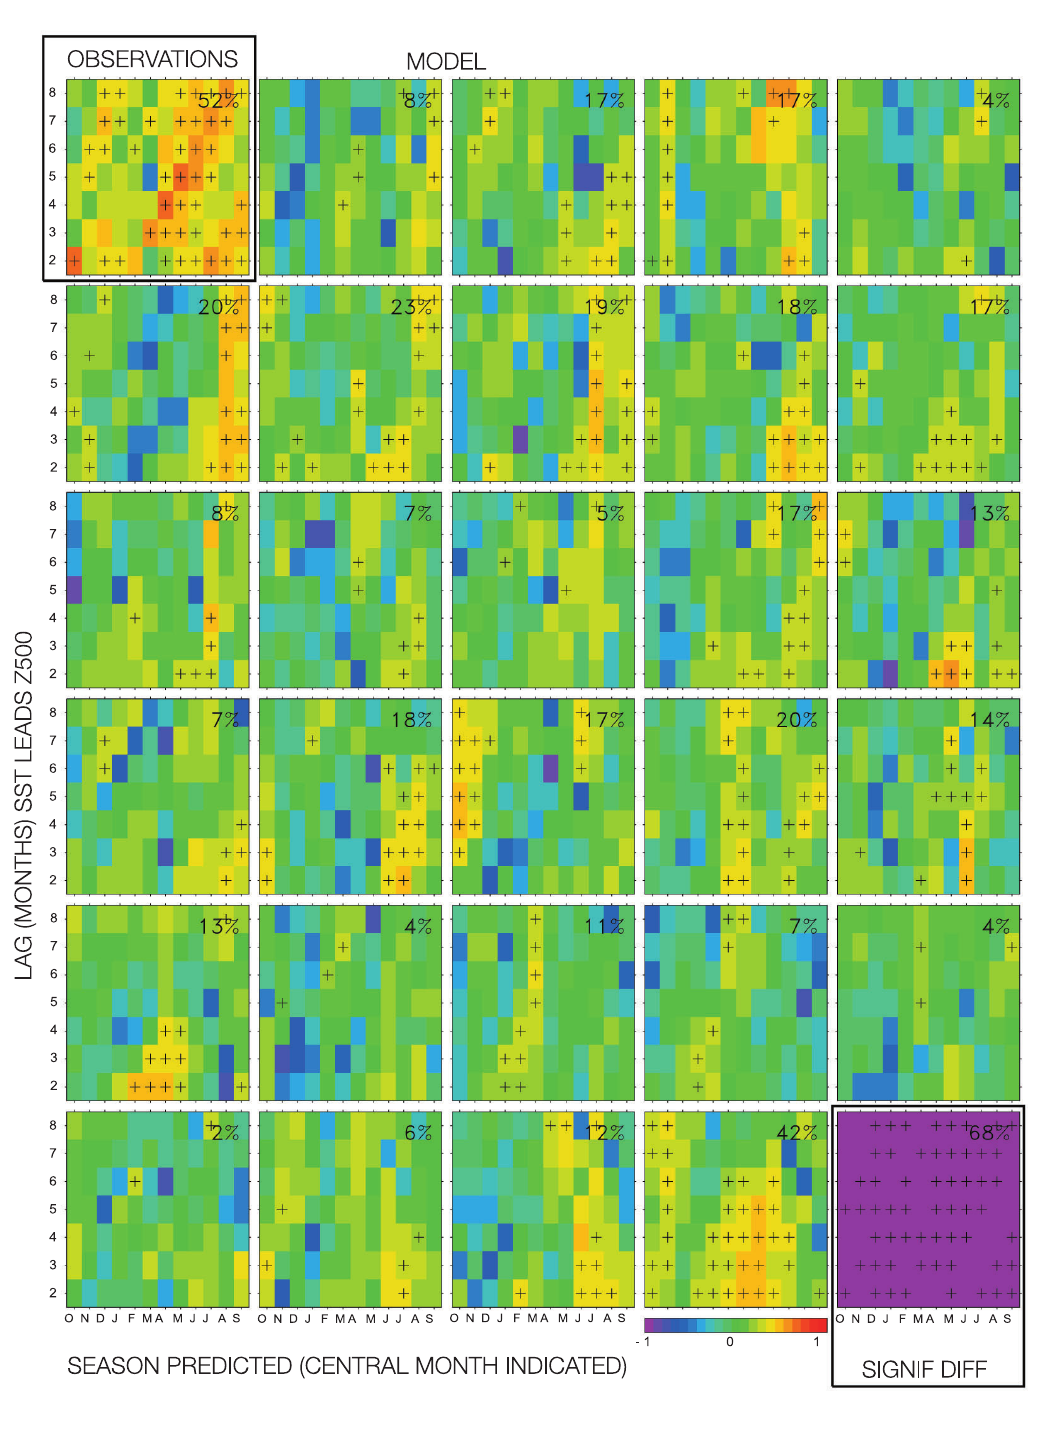
Fig. 2. Cross-validated correlation COR values (see Section 3 for defi nition) from the analysis of the observations (upper left panel) and 28 periods of the OAGCM (HadCM3) - remaining panels except lower right. COR values are given for all SST lead-times up to 8 months. The months on the x -axis indicate the central month of the atmospheric season being predicted. For example, square D7 indicates May SST leading NDJ Z500. Plus signs indicate SST and Z500 confi gurations where the patterns are signifi cant at the 10% level ( i.e. SL < 10%). The percentages indicate the percentage of squares for which SL < 10%. The lower right panel indicates the confi gurations for which the observational COR values exceed all but at most two of the 28 model COR values. This occurs for 68% of all squares (as